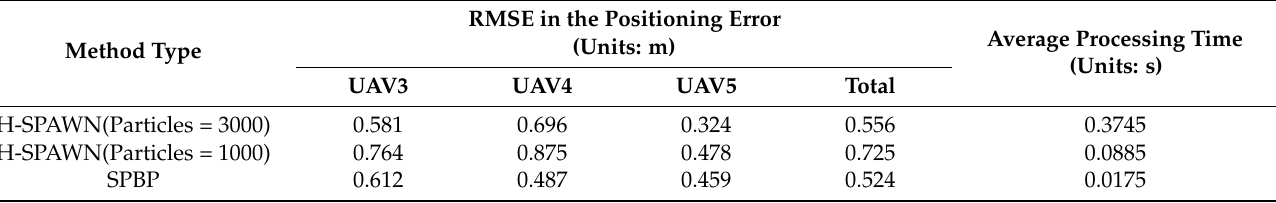
Table 2. Positioning results for several